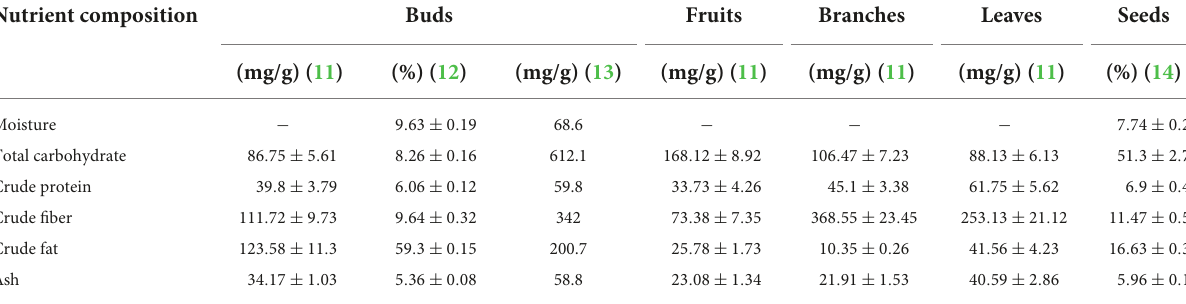
TABLE 1 Conventional nutrients in various parts of S. aromaticum